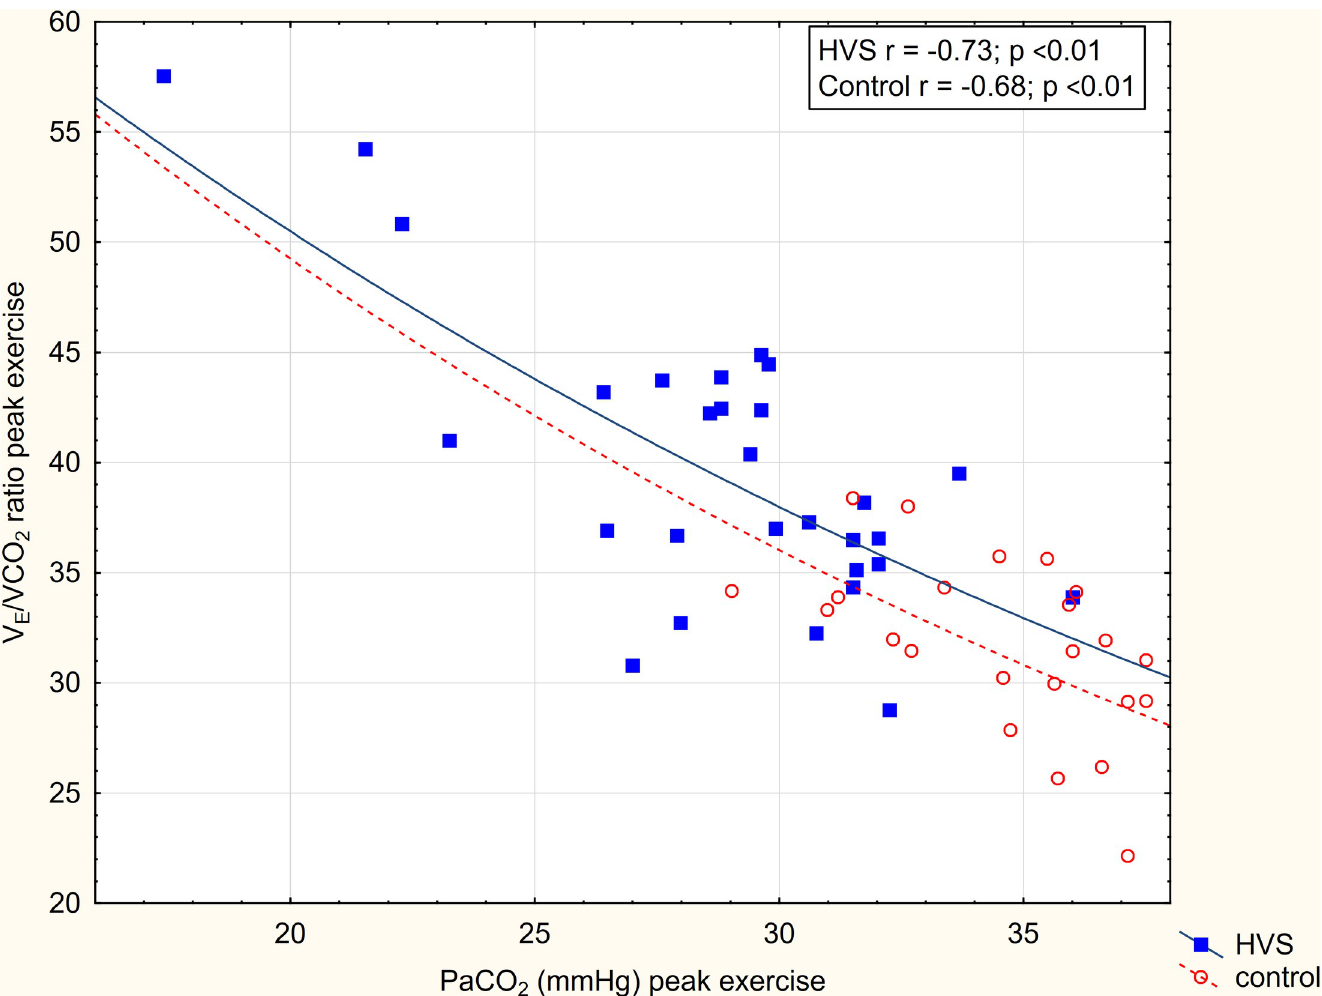
Fig 1. Relation of V E /VCO 2 and PaCO 2 in patients with HVS and controls. Slopes of ventilatory efficiency (V E /VCO 2 ) to partial pressure of arterial oxygen (PaCO 2 ) at peak exercise are compared in patients with HVS and controls. The shift of the slope of this relationship in patients with HVS is consistent with the observed higher V D /V T ratio (i.e. higher ventilation-perfusion